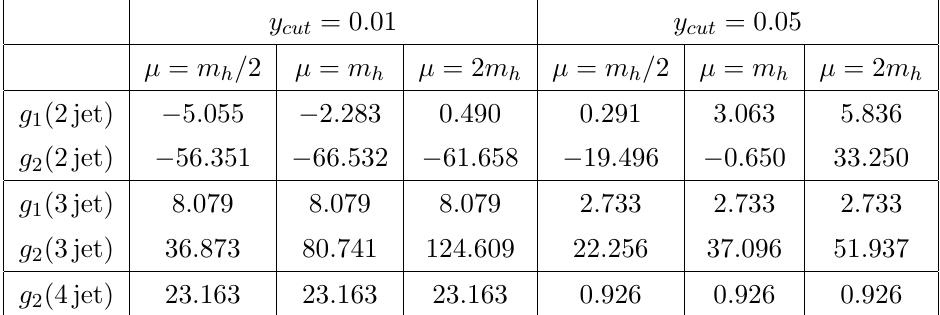
Table 3 . The coe(cid:14)cients g i (n jet) de(cid:12)ned in eqs. (5.6){(5.8) and computed with the Durham algorithm using y cut = 0 : 01 and y cut = 0 : 05 for three renormalization scales (cid:22) . They determine the n -jet rates